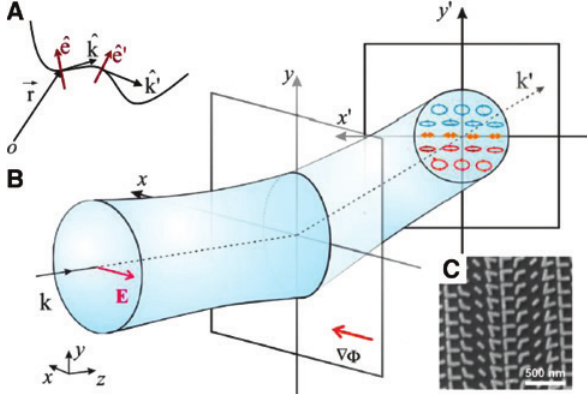
Figure 3: Giant photonic spin hall effect with metasurfaces. (A) Schematic of the PSHE. When light is propagating along a curved trajectory, the polarization of light will rotate accordingly. This is due to the transverse nature of light. (B) PSHE induced by a metasurface with a strong phase gradient along the x -direction. When the light beam is incident onto the metasurface, opposite circular components of the beam accumulate on the opposite side in the transverse directions. (C) Scanning electron microscopy (SEM) image of the fabricated metasurface. Reprinted from Ref. [21]. Copy- right © 2013 by the